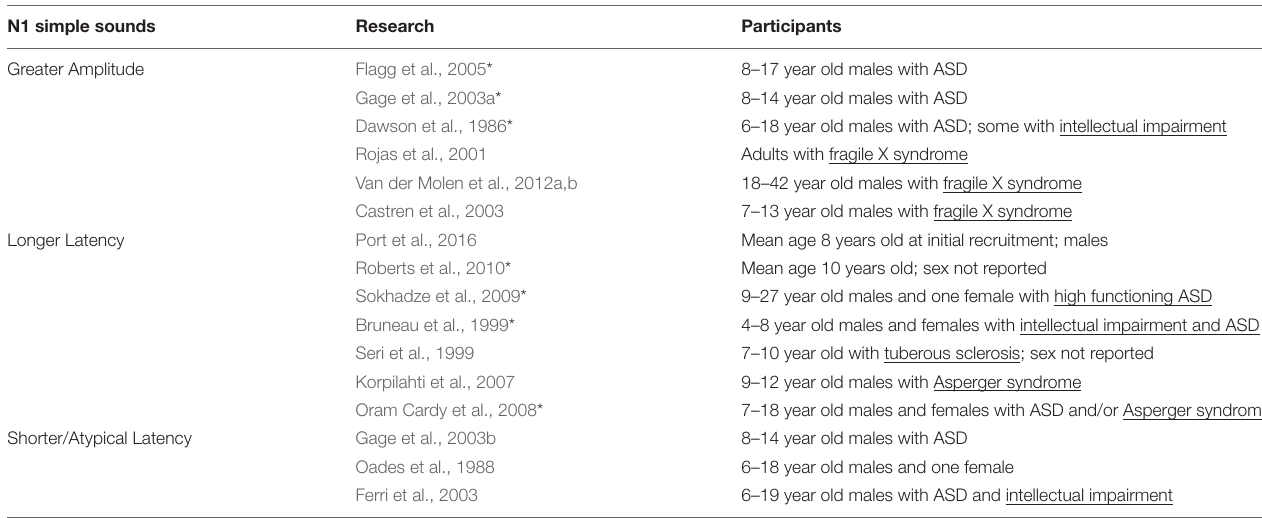
TABLE 2 | N1 peak in response to simple sound